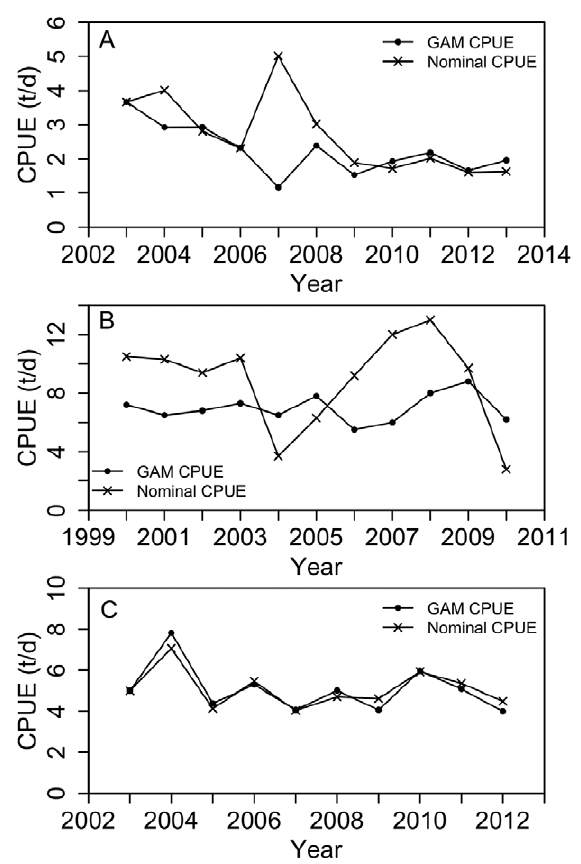
Fig. 2. – Nominal and GAM-standardized CPUEs for O. bartramii in the northwest Pacific in 2003-2013, I. argentinus in